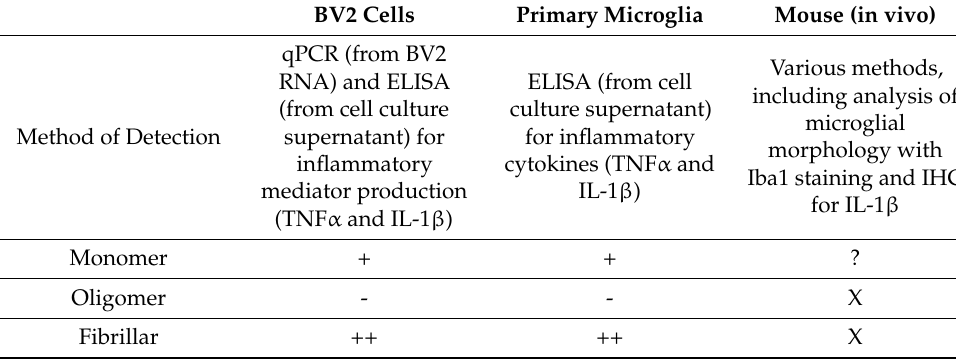
Table 1. Interaction of microglia with different aggregation states of α -syn. A summary of the ability of different aggregation states of α -syn to activate microglia as seen in the BV2 cell line, murine primary microglia and in vivo in a mouse brain, along with the method of detection used. The strength of the activation is shown for in vitro work by strongest (++), strong (+), or absent (-), whereas in vivo work is marked as present (X) or unknown (?). BV2 Cells Primary Microglia Mouse (in vivo) qPCR (from BV2 Various methods, ELISA (from cell RNA) and ELISA including analysis of culture supernatant) (from cell culture microglial for inflammatory supernatant) for Method of Detection morphology with cytokines (TNF α and inflammatory Iba1 staining and IHC IL-1 β ) mediator production for IL-1 β (TNF α and IL-1 β ) Monomer + + ? Oligomer - - X Fibrillar ++ ++